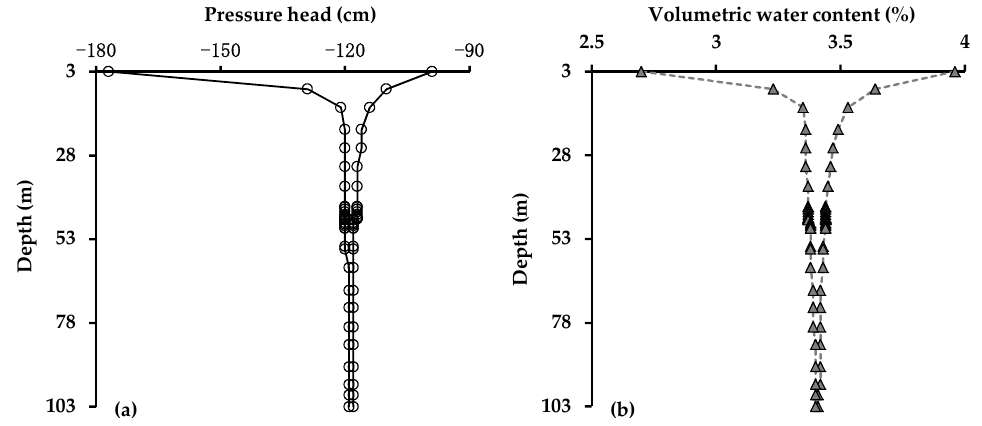
Figure 6. The depth-dependent maximum and minimum values of the pressure head ( a ) and volumetric water content ( b ) in the deep zone, according to numerical modeling results.